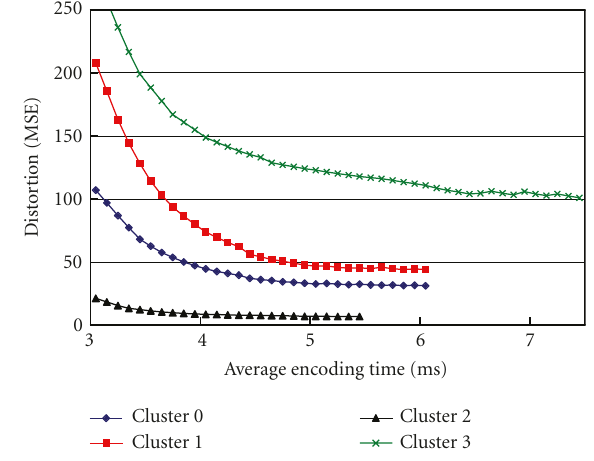
Figure 9: The relationship between average encoding time and dis- tortion for the center of each